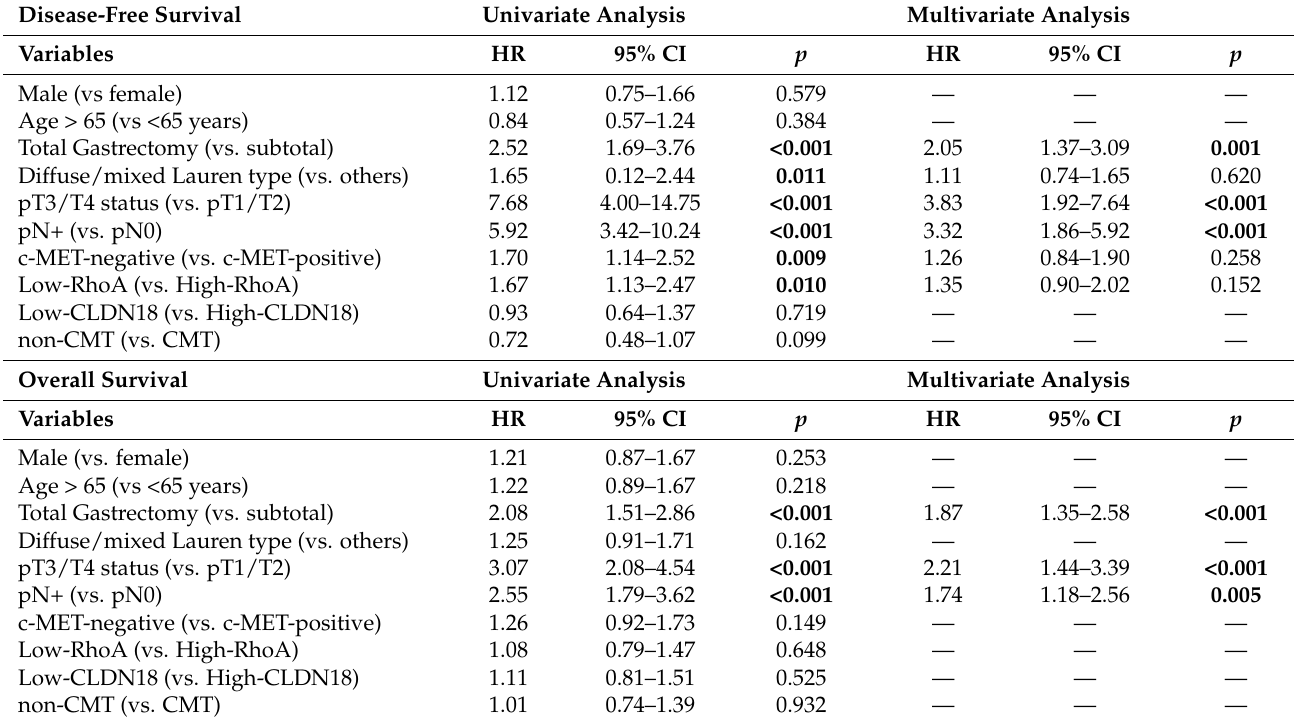
Table 4. Univariate and multivariate analysis for disease-free survival (DFS) and overall survival